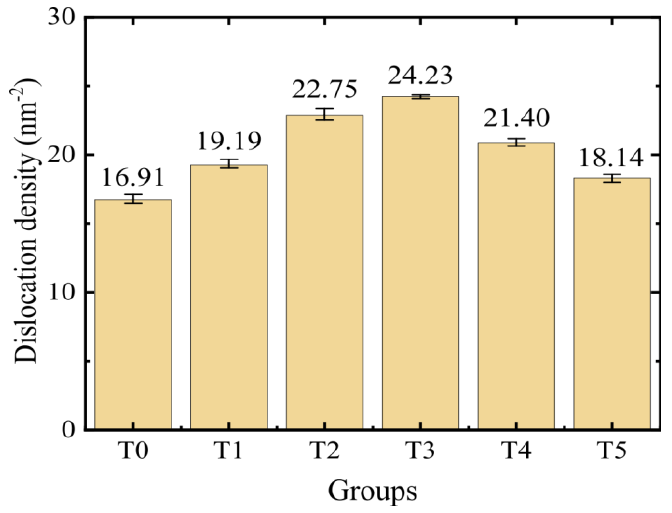
The dislocation density results in the surface layer of groups T0–T5 are shown in Figure 8. The dislocation density of control group T0 was 16.91 nm − 2 . It can be seen that the dislocation density of groups T1–T5 increased compared with control group T0, which were 19.19 nm − 2 , 22.75 nm − 2 , 24.23 nm − 2 , 21.40 nm − 2 , and 18.14 nm − 2 , respectively. Dislocation is a physical property of the material and plays a vital role in plasticity, hardness, and wear resistance [28,29]. When the dislocation density of the material is more significant, dislocations accumulate more around the grain or matrix structure to form the tangled and stacked dislocation, dramatically raising the deformation resistance of the grain and microstructure, thus becoming more stable and having a strengthening effect. It can be preliminarily shown that the surface layer of the 30CrMnSiA specimen was strengthened by the SMGT treatment.